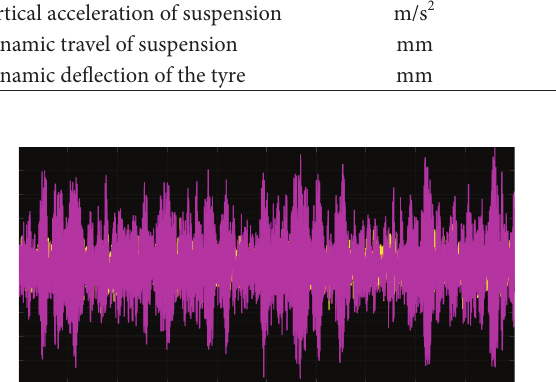
Figure 5: Dynamic deflection of the active and passive